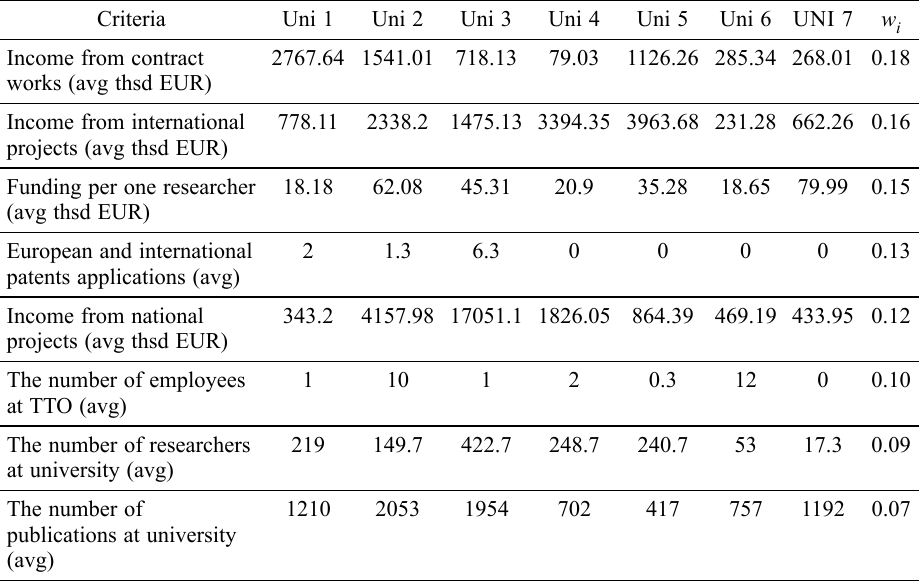
Table 11. Weights were calculated based on FARE method and value average data were taken from seven biggest Lithuanian universities from the period 2011–2013 year